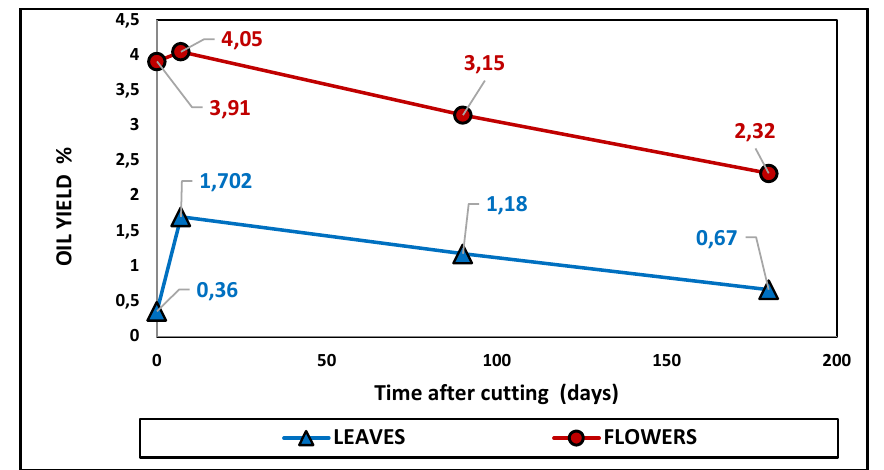
Figure 2. The effect of time after cutting on M. pulegium essential oil extraction operating conditions (temperature 80 °C, extraction time 60 min and water: material ratio 20